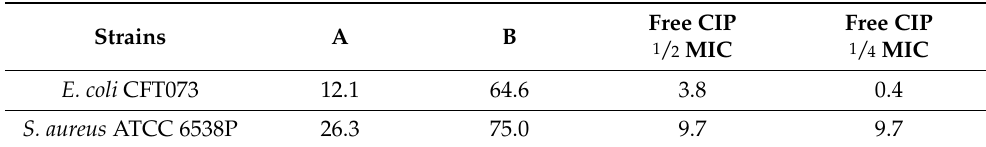
Table 5. Percentage of biofilm inhibition by sub-MIC niosomes. Values higher than 40% were considered relevant in biofilm